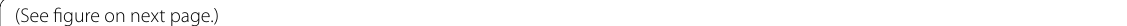
figure on next Fig. 1 a The fermentation results of different bacterial strains (10 strains in total) for 7 days showing the final concentration of Si released during the fermentation of rock samples; b the final concentrations of released elements K + , Al 3 + and Si 4 + from the rock samples by the NLX-4 strain and particle diameter variations (PDV); c Pearson’s correlation analysis of PDV of the fermented rock samples; exopolysaccharides (EPS); acetic acid (AA); oxalic acid (OA); citric acid (CA); tartaric acid (TA); malic acid (MA). Symbols *, **, and *** represent that the correlations are significant at 0.5, 0.01, and 0.001 levels, respectively. Error bars represent the standard deviation ( n =